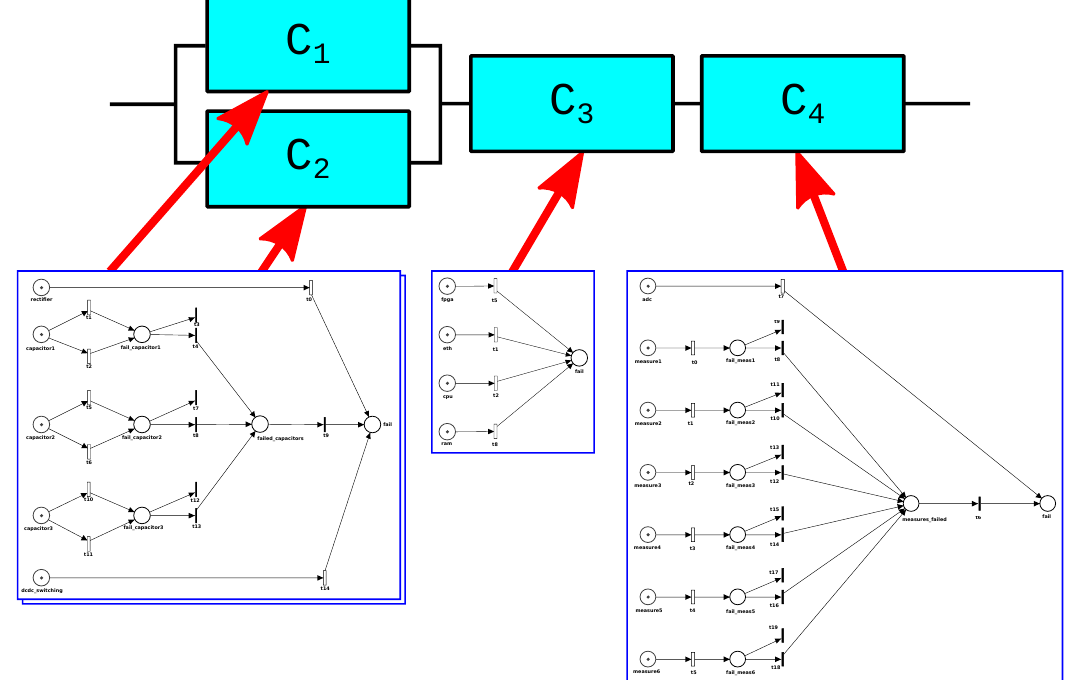
Figure 1. Example of layered reliability